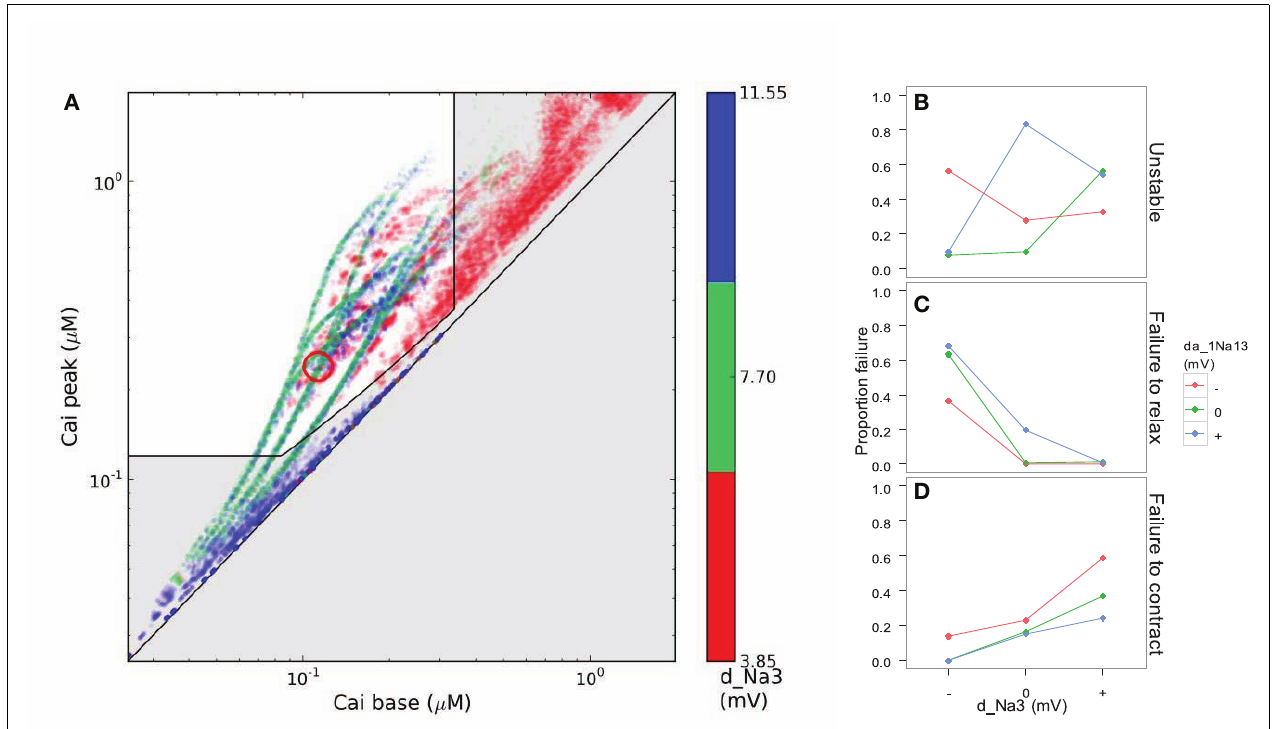
sodium channel. (B) Interaction of d_Na3 and da_1Na13 (voltage-sensitivity of the rate of recovery from inactivation) with respect to the proportion of simulated genotypes that converged to stable dynamics.The middle and bottom panels show the proportion of stable scenarios suffering from excessive base levels of cytosolic calcium (C) or insufficient peak calcium (D)